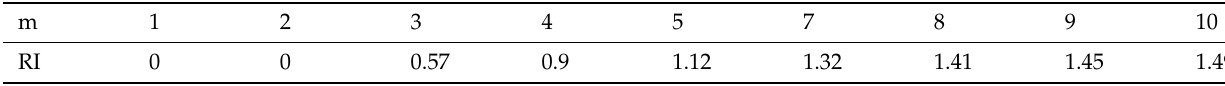
Table A5. RI of low order judgment matrix.